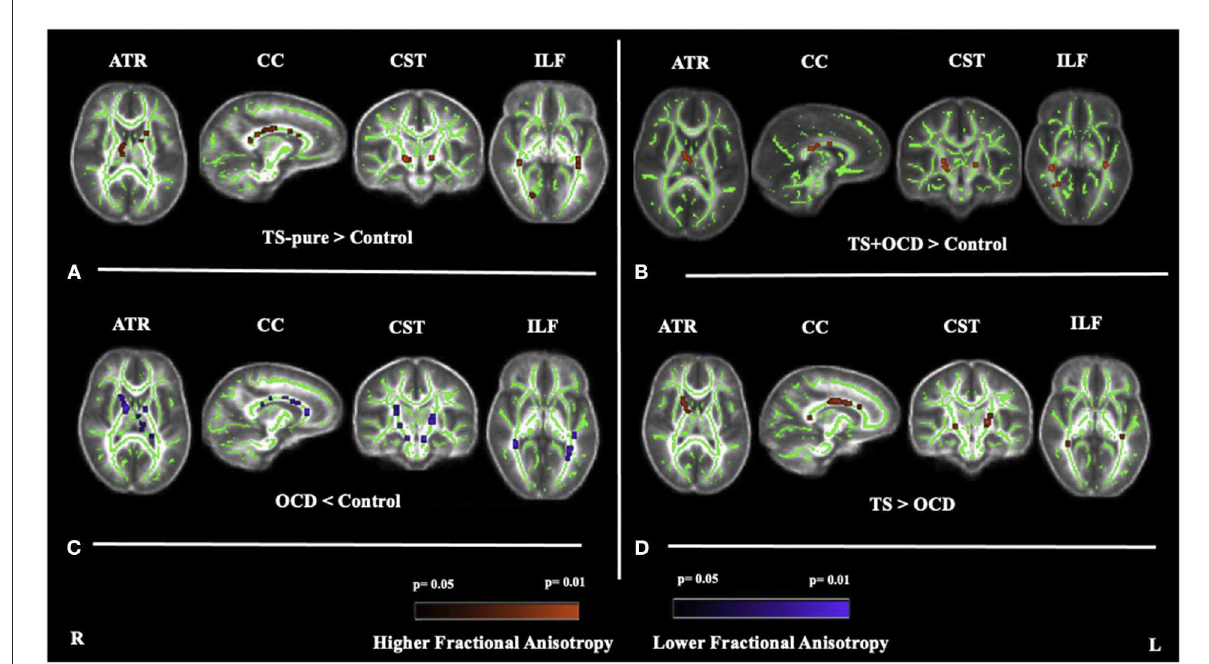
FIGURE1 Fractional anisotropy (FA) differences between (A) TS-pure and controls, (B ) TS + OCD and controls, (C) OCD and controls, (D) TS and OCD, at anterior thalamic radiation (ATR), corpus callosum (CC), corticospinal tract (CST), inferior longitudinal fasciculus (ILF). (A) : higher FA in TS-pure than in controls, (B) : higher FA in TS + OCD than in controls, (C) : lower FA in OCD than in controls, (D) : higher FA in TS than in OCD. Results were obtained within the mask of ATR, CC, CST, and ILF. Results are presented in the whole brain FA skeleton mask derived from the complete set of participants. FA results were corrected for multiple comparisons at the false discovery rate (FDR) of p < 0.05. Red color: Higher FA differences, Blue color: Lower FA differences, TS-pure: participants with pure Tourette syndrome (TS), OCD: participants with obsessive compulsive disorder, TS + OCD: TS participants with comorbid condition, TS: participants with TS-pure and TS +